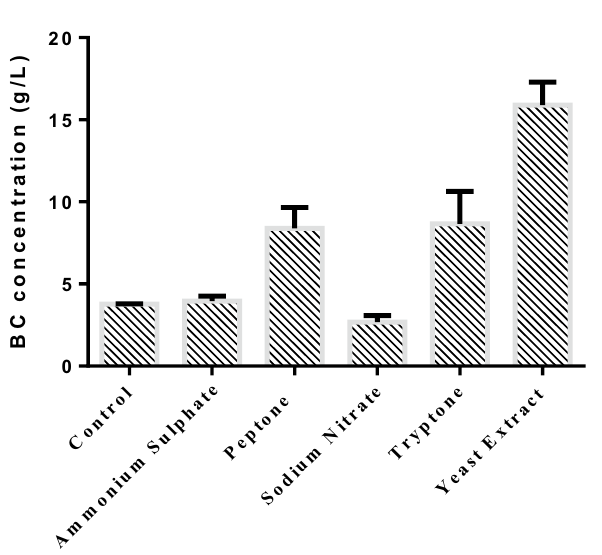
Figure 6. Screening of nitrogen source on the production of BC using immobilized cells with initial pH 5.5 under shaking condition in biofilm fermentation (inoculum size: 5%, v/v, fermentation time: 15 days; initial pH